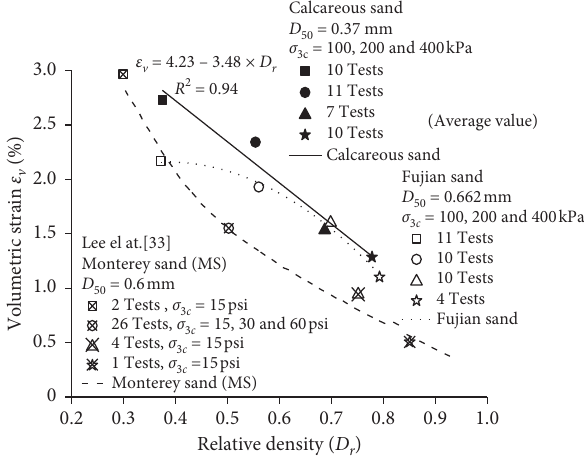
Figure 19: ε D curve of calcareous sand, Fujian sand, and V ∼ r Monterey sand